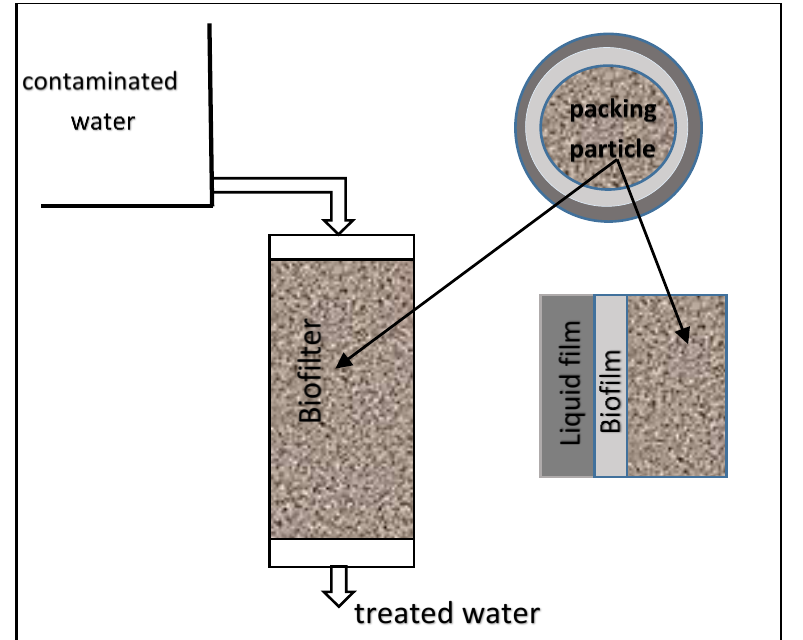
Figure 1. Liquid-phase biofilter concept.